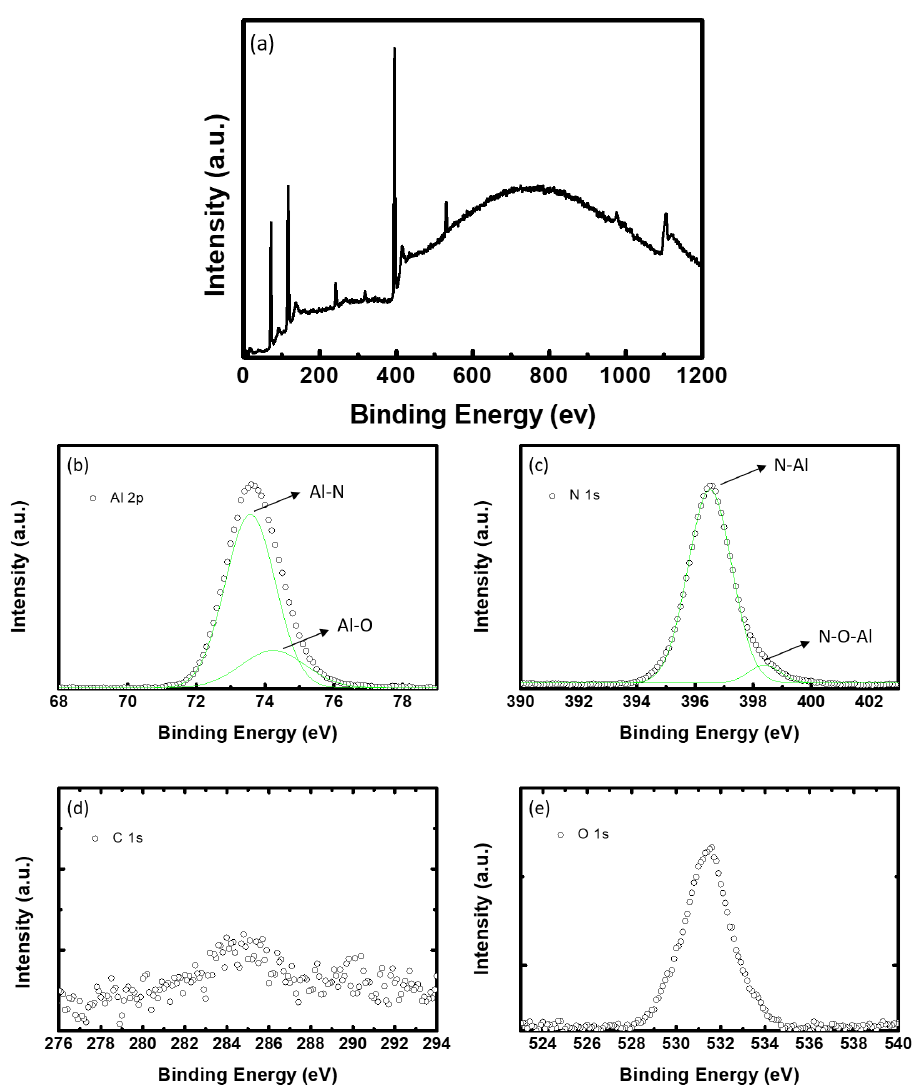
Figure 9. ( a ) Wide-scan XPS spectra and high-resolution XPS spectra of the ( b ) Al 2p, ( c ) N 1s, ( d ) C 1s, and ( e ) O 1s of the ALD AlN (NH 3 plasma power: 30 W).